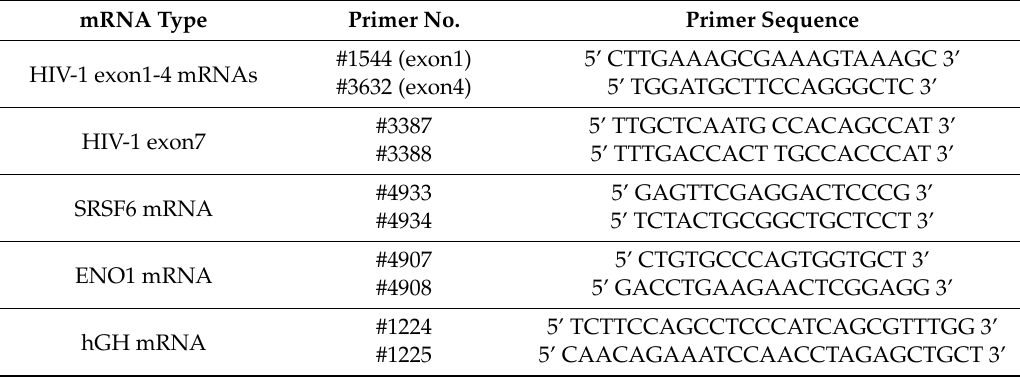
Table 2. DNA oligonucleotides used for semi-quantitative